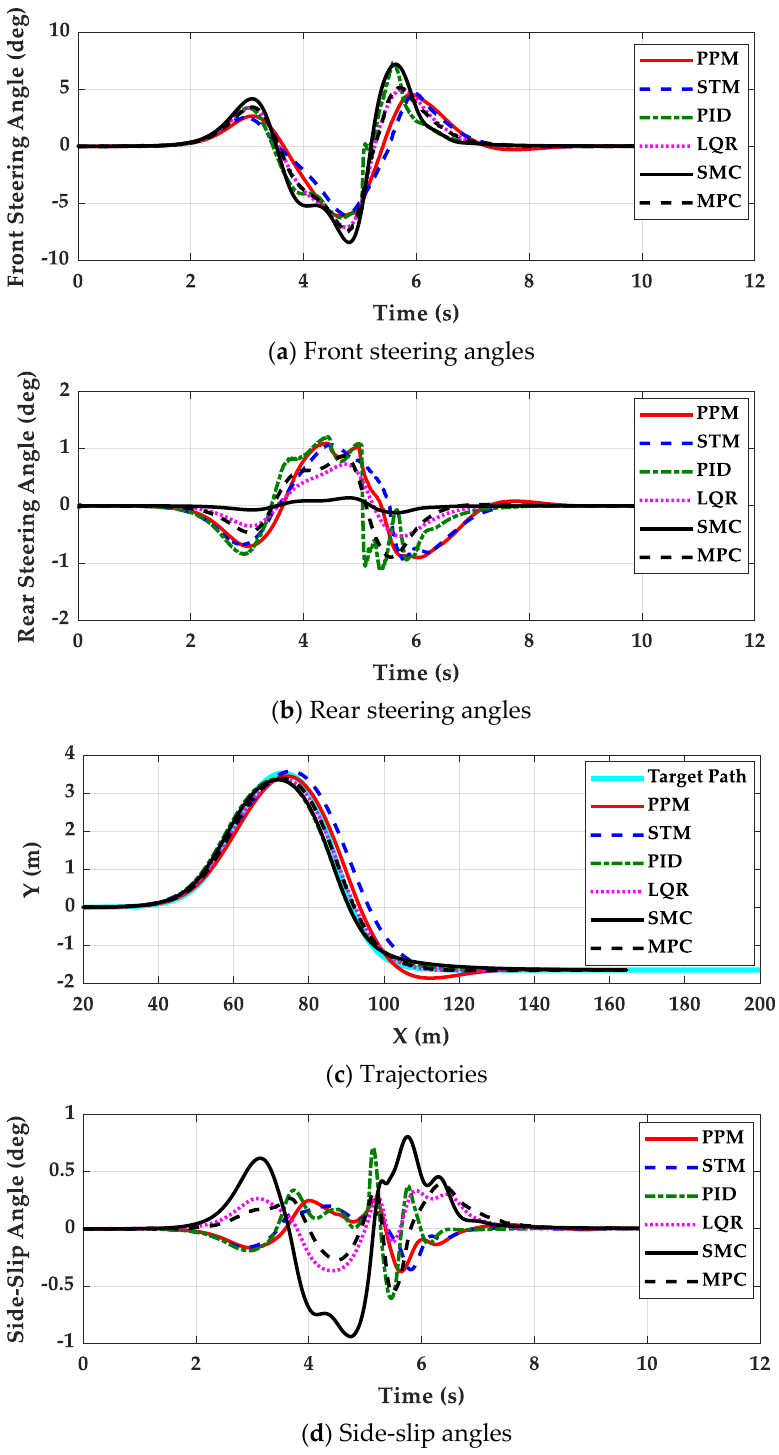
Figure 11. Simulation results of each controller for 4WS vehicle on high- µ road obtained from the fourth set of sim- ulations.